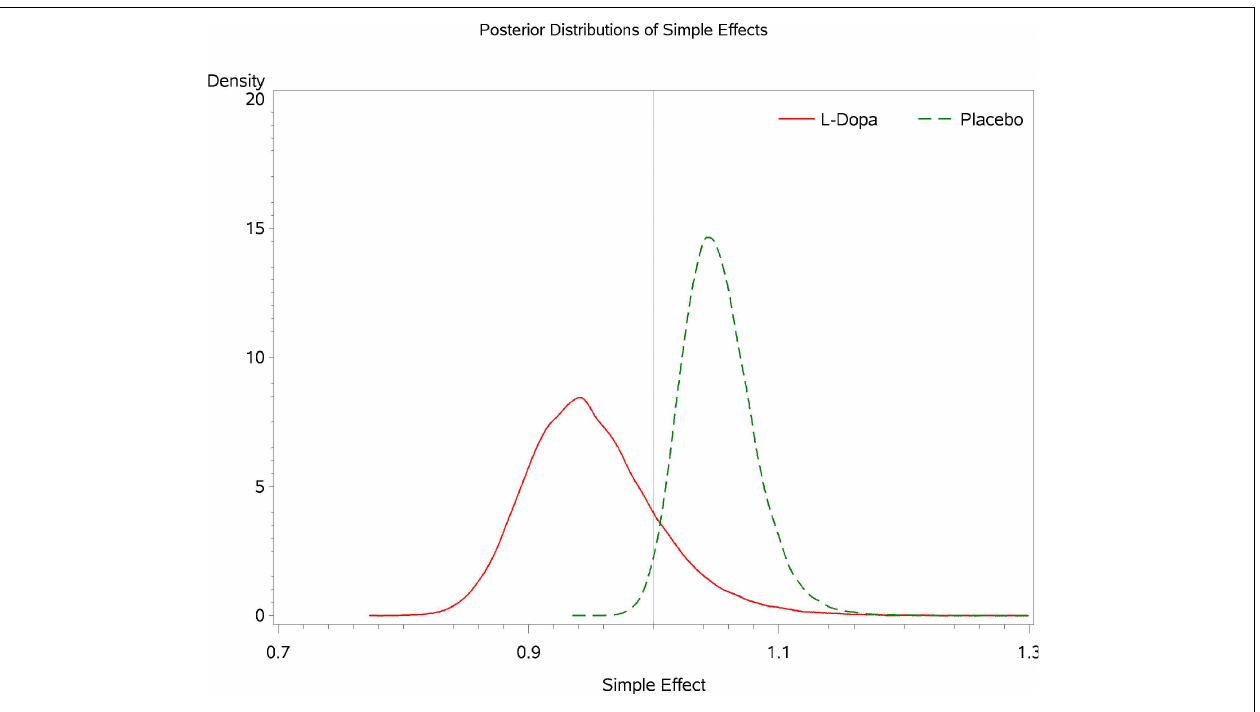
FIGURE 5 |TES as a function of baseline marijuana and treatment condition.